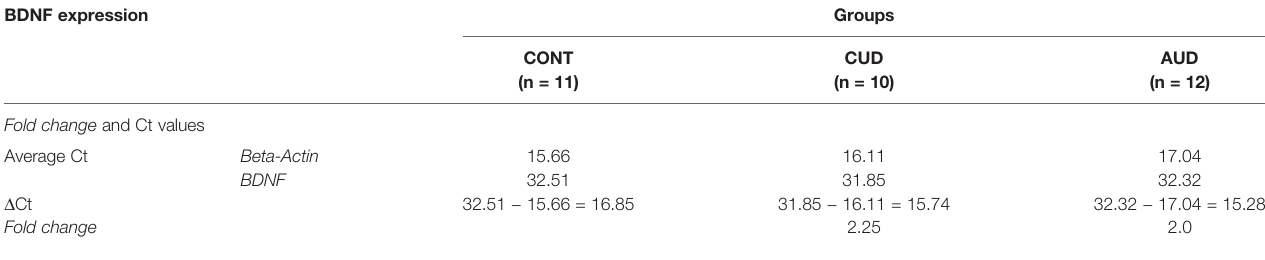
TABLE 2 | BDNF mRNA expression in control subjects (CONT, n = 11), crack-cocaine use disorder (CUD, n = 10) and alcohol use disorder (AUD, n = 12) patients. BDNF